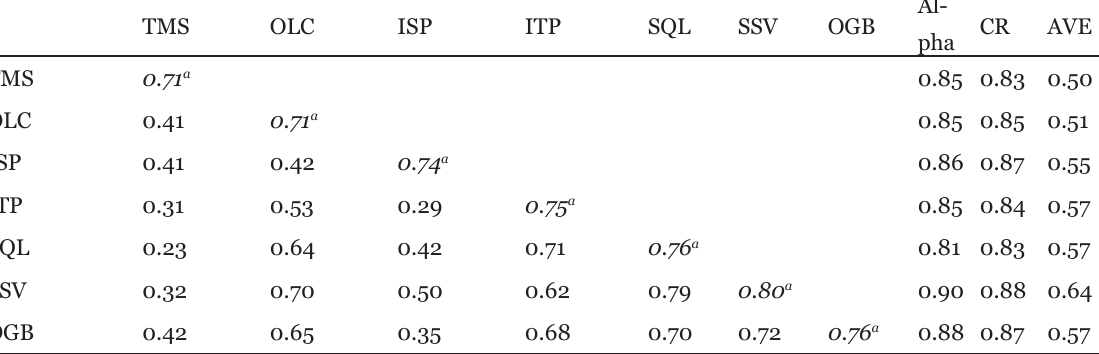
Table 2 AVE, Square Root of AVE, Alpha, CR, and